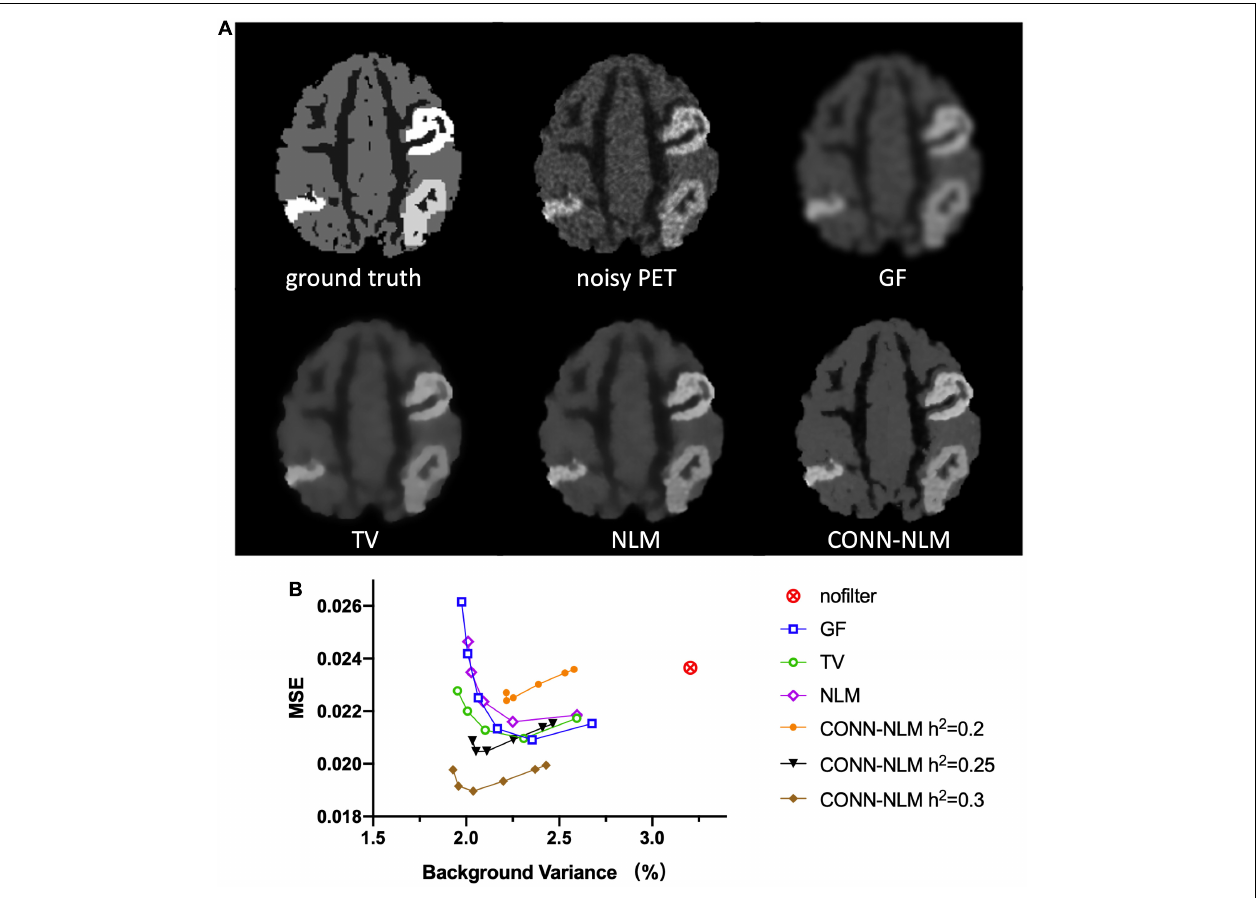
FIGURE 7 | Denoising effects on the high-count simulated PET data. (A) From left to right and from top to bottom: ground truth noiseless image, unfiltered noisy PET image, Gaussian filtering (GF), total variation (TV), non-local means (NML) filtering, and the proposed CONN-NLM filtering. (B) Mean squared error (MSE) for the whole image plotted against the normal GM noise variance (%). For each filter, six points were chosen to produce approximately the same range of noise variance, by varying the corresponding filter parameter.